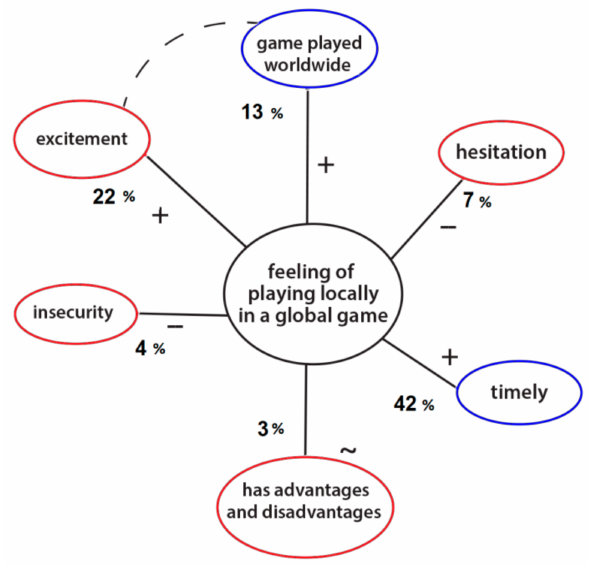
Figure 3. Subthemes with percentages of mentions related to the main thematic “feeling of playing locally in a global game” (question 3). Two subthemes were mentioned more than once (with dotted lines). Subthemes in red relate to the user, and those in blue to the game. The signs +, − , and ~ represent the learners’ disposition towards the subtheme to which these signs relate (positive, negative, and neutral disposition,